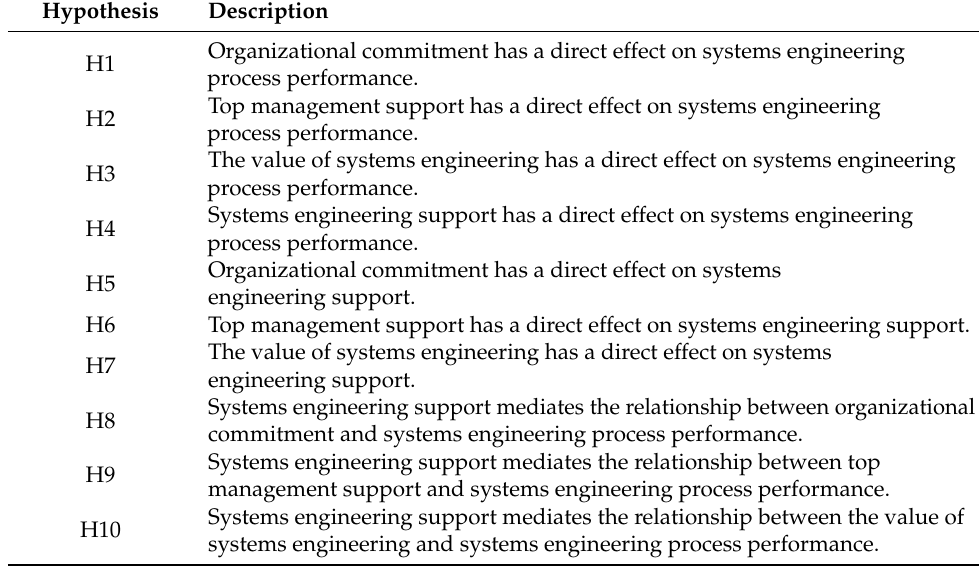
Table 1. Research Table 1. Research Hypotheses.